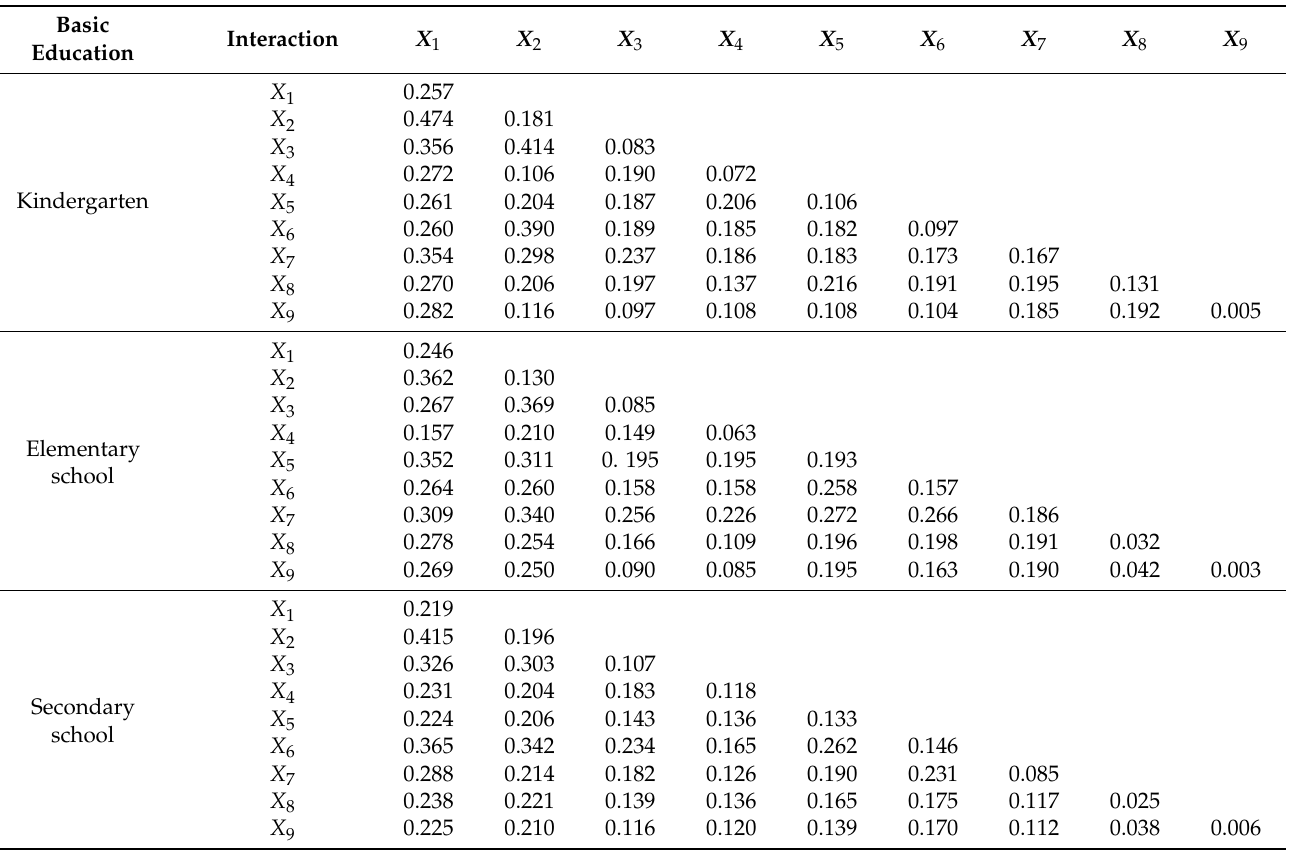
Table 6. The results of interaction